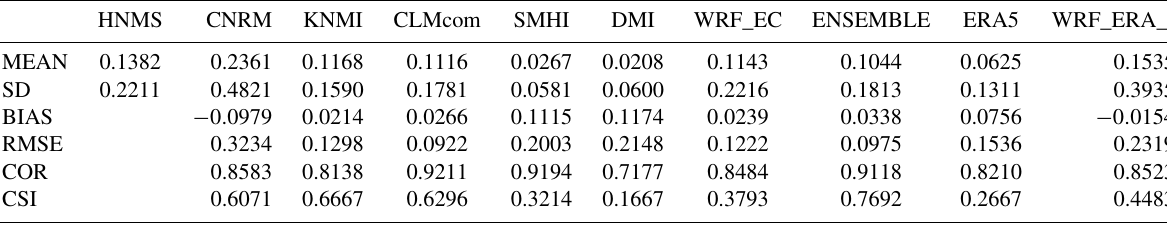
Table 4. Table exhibiting mean (MEAN) station RR20FD empirical probabilities (%) for observations and models, standard deviation (SD), bias (BIAS), rmse (RMSE), Pearson correlation (COR), and CSI of models against observations.